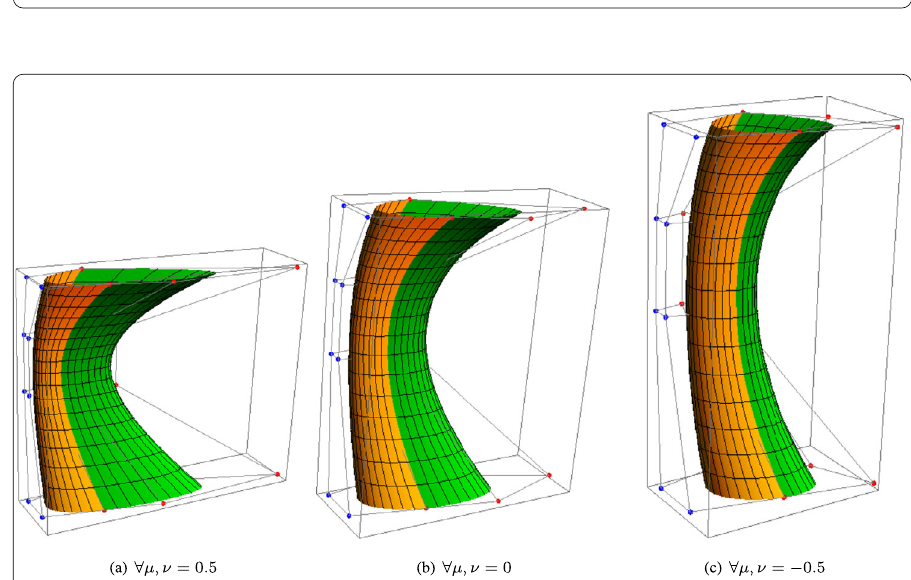
Figure 18 C 2 continuity between two GBT-Bézier swung surfaces with λ =